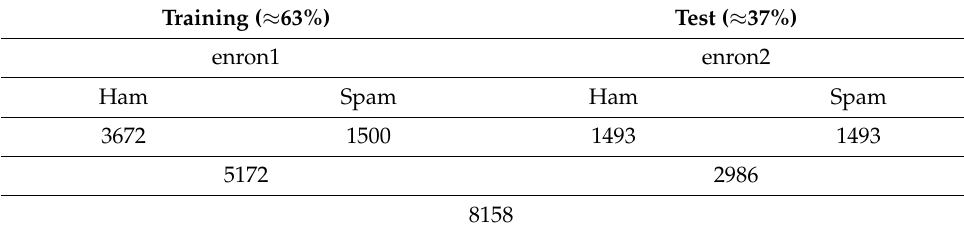
Table 5. Dataset 2